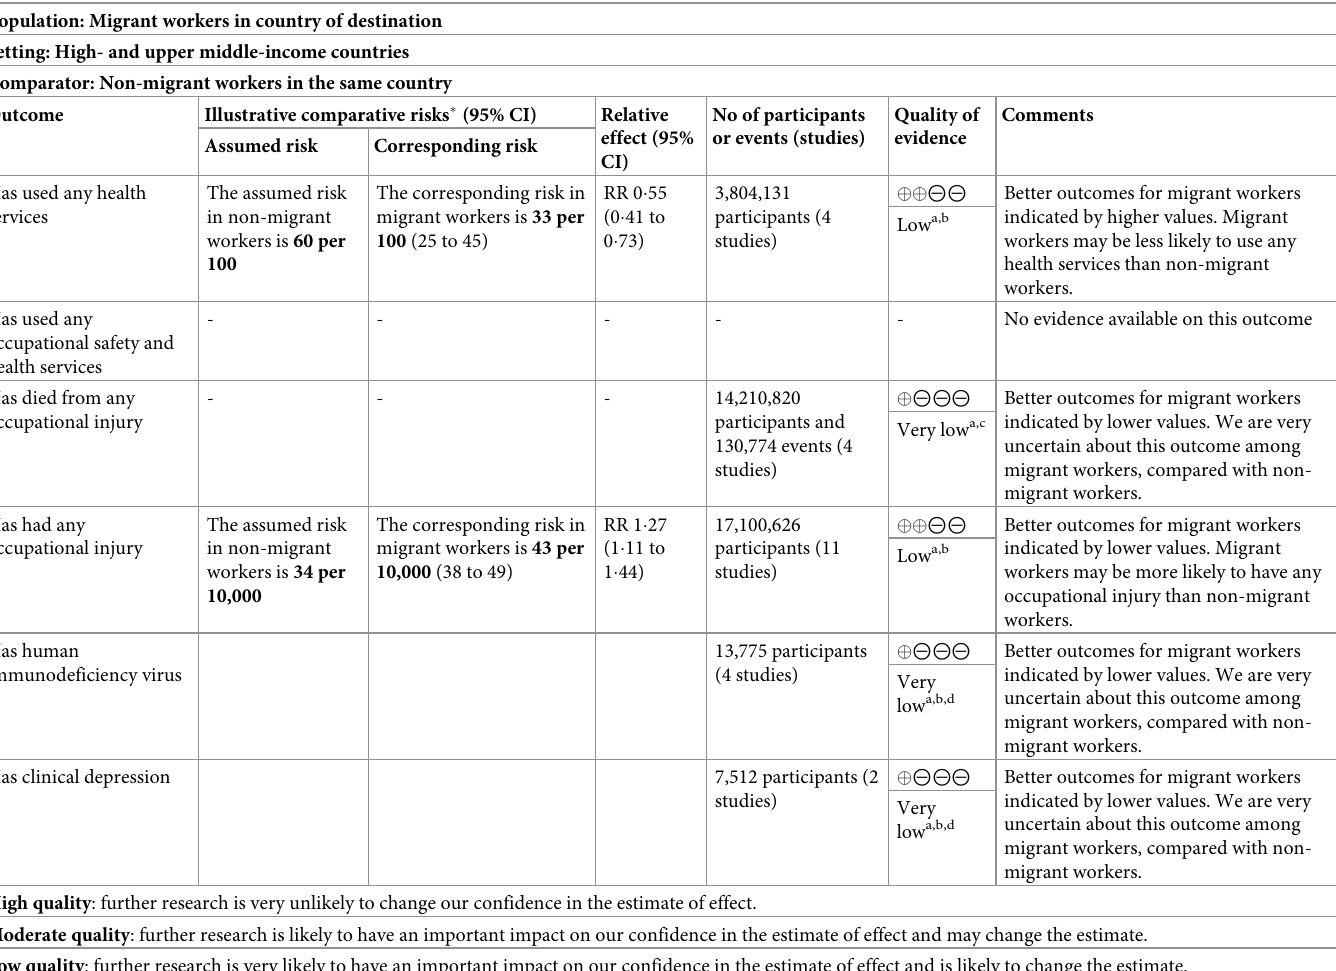
Table 3. Summary of findings: Use of health services and health outcomes among migrant workers compared with non-migrant workers. Population: Migrant workers in country of